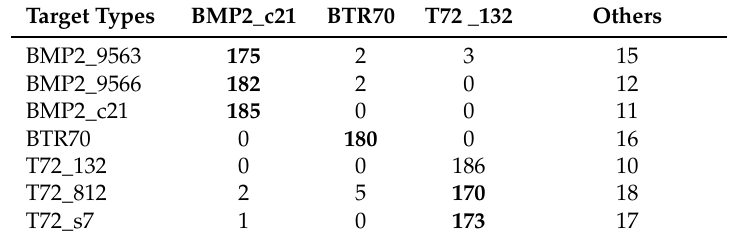
The number of “in-targets” HRRP sequences in the test set = 1365.